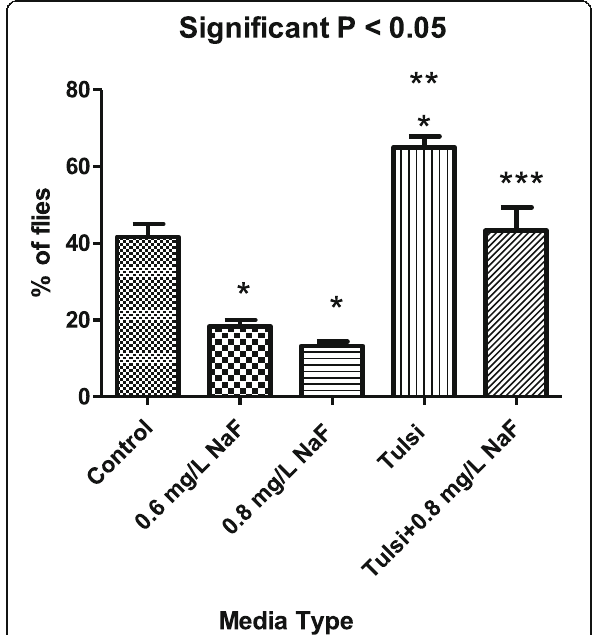
Fig. 2 Climbing ability of Drosophila melanogaster after 03 days of eclosion. *, significant difference between control vs NaF; **, significant difference between tulsi vs NaF; ***, significant difference between tulsi + F in medium vs NaF